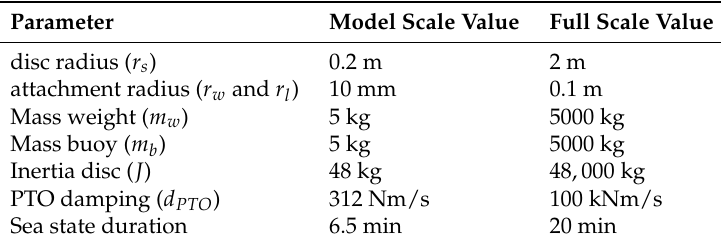
Table 1. Parameters of the scale model and their Froude-scaled full scale